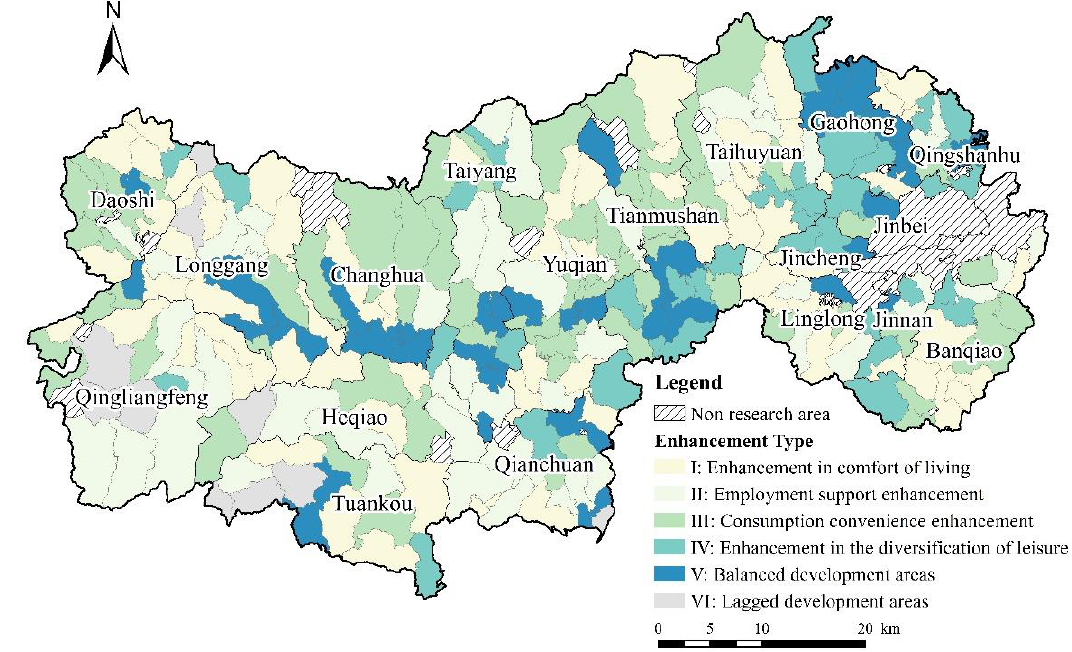
Figure 11. Distribution of enhancement types of QRL.